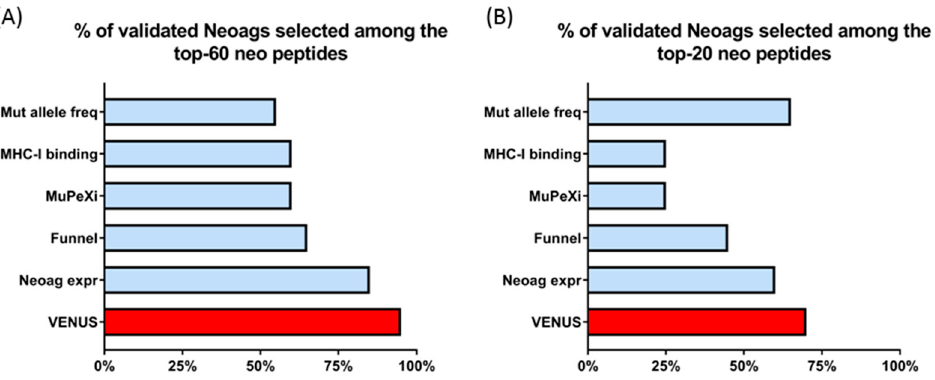
Figure 3. Comparison of VENUS performance against alternative methods that include less parameters. Light blue bars represent the percentage of validated neoantigens included in the top 60 ( A ) or top 20 ( B ) selection performed using the indicated alternative single or combination of parameters. For comparison, the percentage of validated neoantigens included within the top 60 ( A ) or 20 ( B ) neoantigens by VENUS. Funnel filtering is performed by retaining only the neo-peptides predicted as major histocompatibility complex (MHC)-I binders (9 mer; predicted IC50 ≤ 500 nM) and encoded by an expressed gene (transcripts for million (TPM) ≥ 0.50).